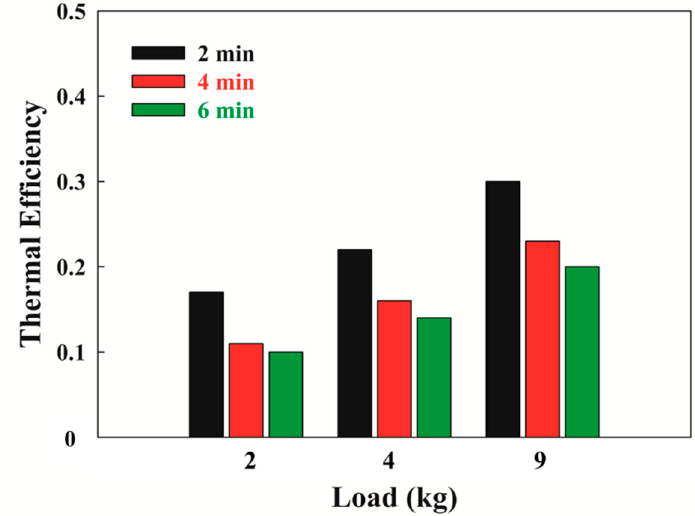
Figure 9. Effect of WG loading on the dehydration time, heating time, and water activity with different loading, from 2 to 9 kg, at 120 ◦ C. Dehydration time ( (cid:78) ), heating time ( (cid:8) ), and WA ( (cid:4) ); the lines represent the fitting value.